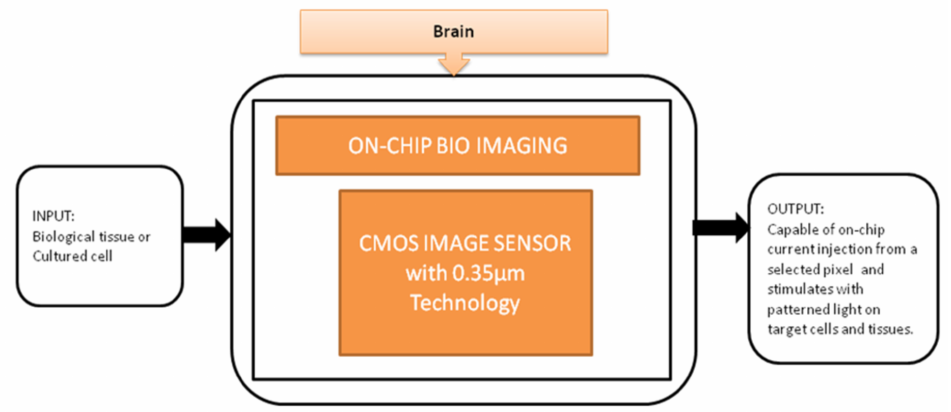
Figure 17. On-chip bio